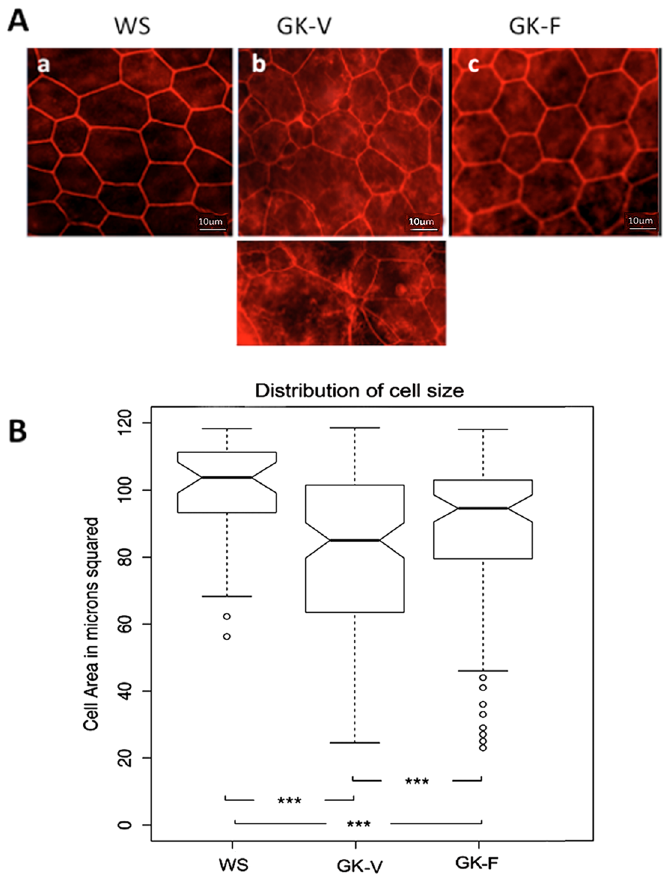
Figure 6. Effect of intravitreal Fasudil on RPE cell layer morphology. ( A ) Phalloidin-stained actin on flat- mounted RPE from GK rat treated in vivo with vehicle (GK-V) or with fasudil (GK-F). Polydispersed size of RPE with apical constriction and stress fibers in GK-V rats (b) is reverved in GK-F rats (c). Scale bar = 10 µ m. ( B ) boxplot summarizing the distribution of small cells in control rats (WS) and in diabetic rats (GK) treated by Fasudil (F) or vehicle (V). The RPE of GK Fasudil treated rats had significantly less small cells than the RPE of GK vehicle treated rats, suggesting less cellular constriction (n = 7 per experiment). *** p value <